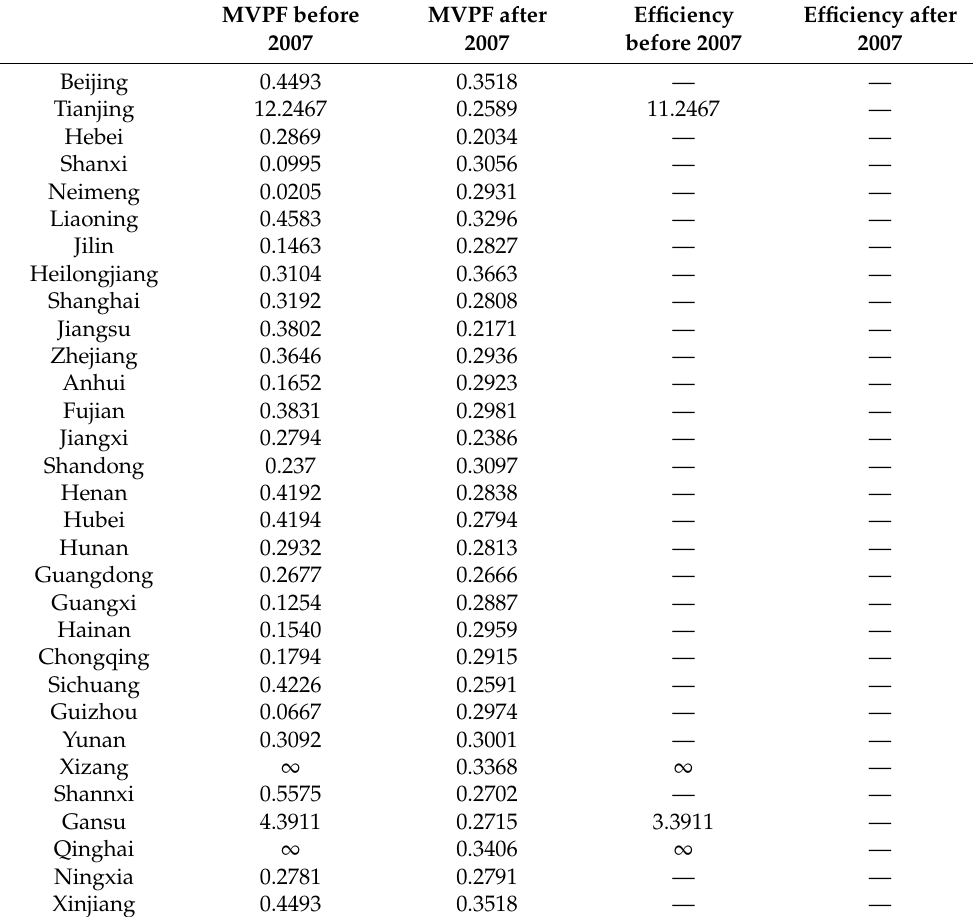
Table 4. MVPFs and Efficiency of Subsidized Agricultural